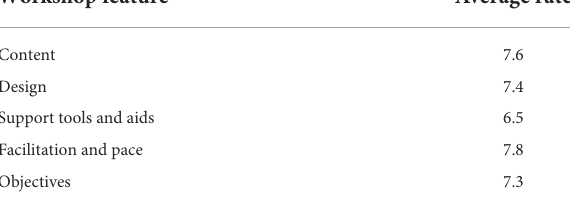
TABLE 4 MFP workshop ratings: 1 denotes low and 10